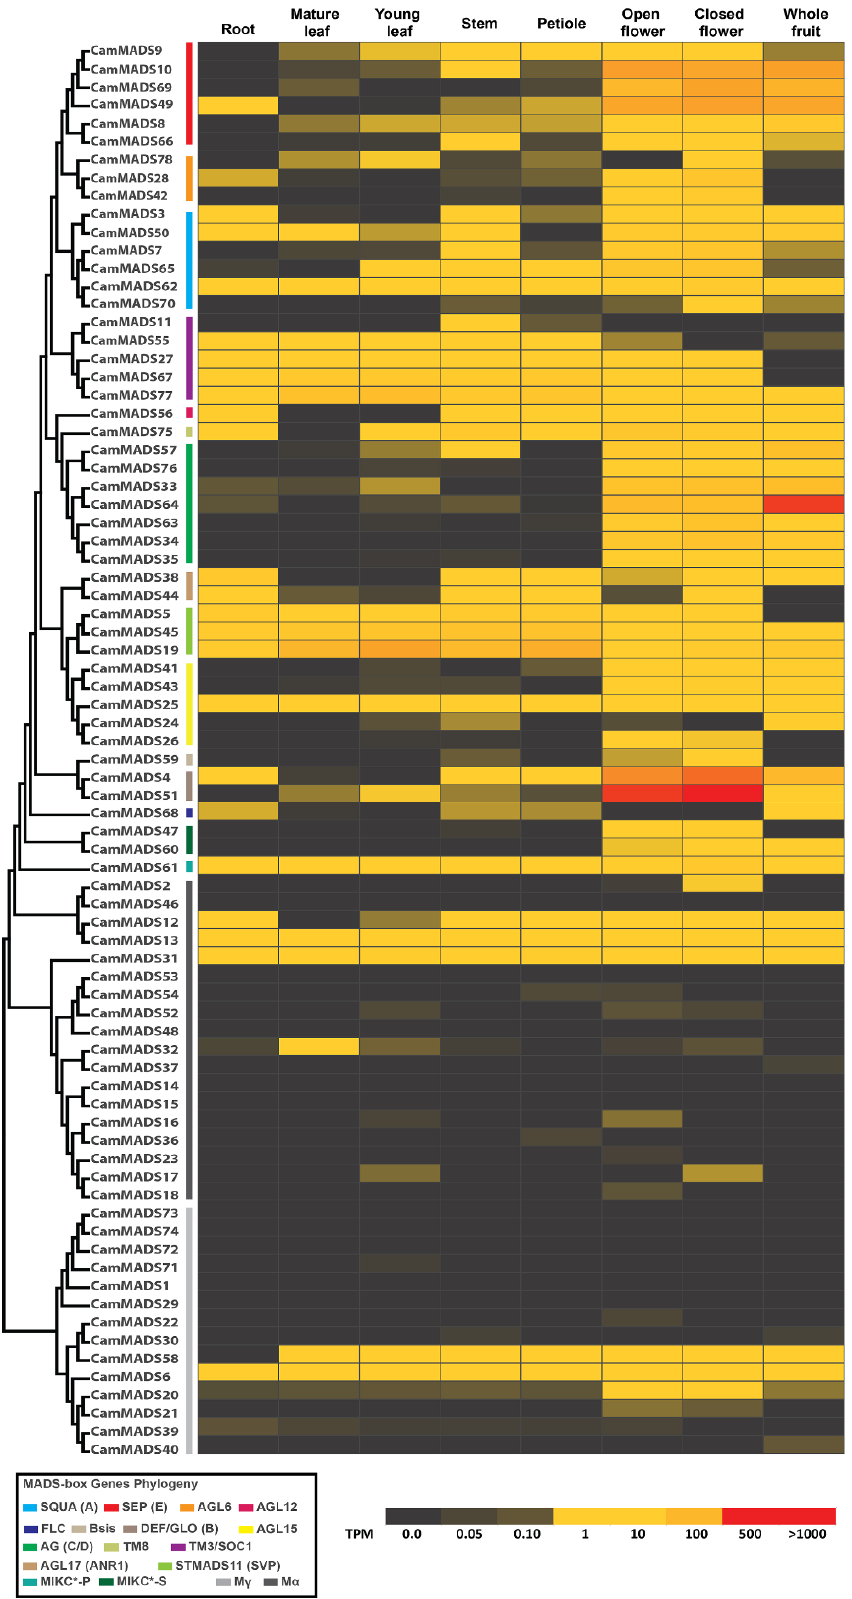
Figure 6. Heatmap of CamMADS genes expression level (TPM) is each of the following tissues: root, mature leaf, young leaf, stem, petiole, open flower, closed flower, and whole fruit. The phylogenetic tree is to the far left, and the box at the bottom left indicates the subgroups of CamMADS genes.